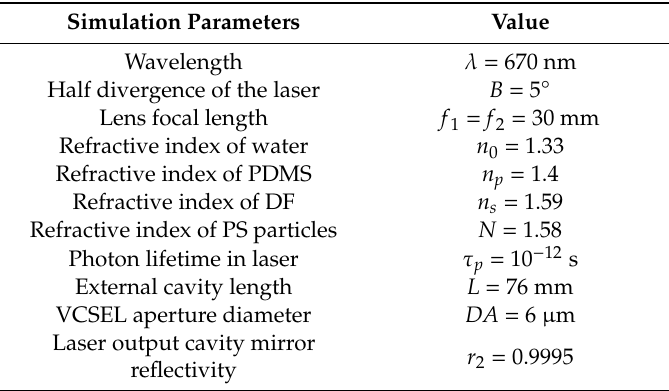
Table 1. ZEMAX modeling parameters